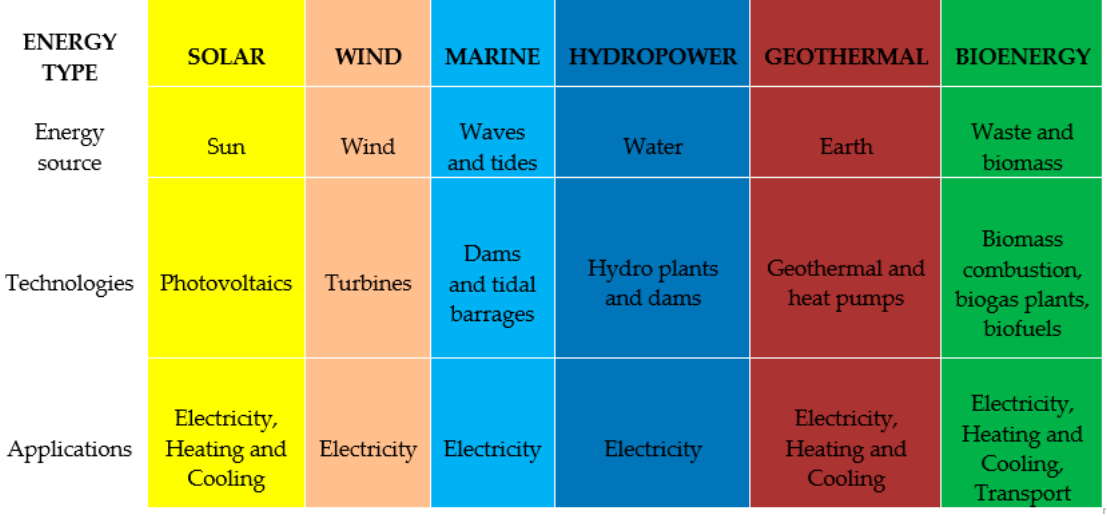
Figure 1. Renewable energy sources, technologies and applications; source: adapted from ECA, 2018 [3].